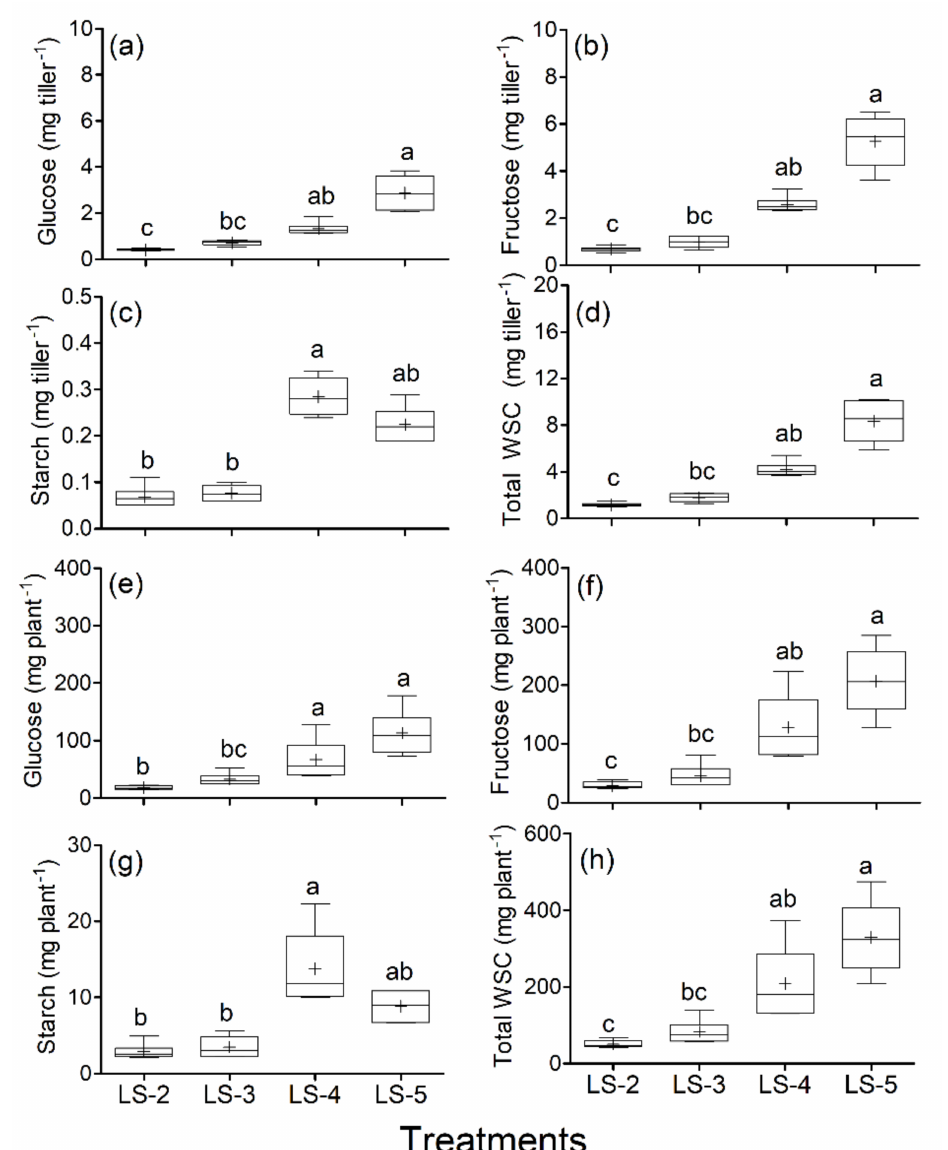
Figure 5. Water-soluble carbohydrates: mg of glucose per tiller ( a ), mg of fructose per tiller ( b ), mg of starch per tiller ( c ), mg of total WSCs per tiller ( d ), mg of glucose per plant ( e ), mg of fructose per plant ( f ), mg of starch per plant ( g ) and mg of total WSCs per plant ( h ) for B. valdivianus defoliated by leaf stage (LS). The defoliation frequencies were based on defoliation at leaf stage 2 (LS-2); leaf stage 3 (LS-3); leaf stage 4 (LS-4); leaf stage 5 (LS-5). The content per plant was determined by multiplying the quantity of the WSCs per tiller by the average tiller population per plant determined at the end of the study. Lowercase letters indicate difference between treatments. + indicates the mean, while bars and boxes are the distribution of the population (quartiles) ( n =